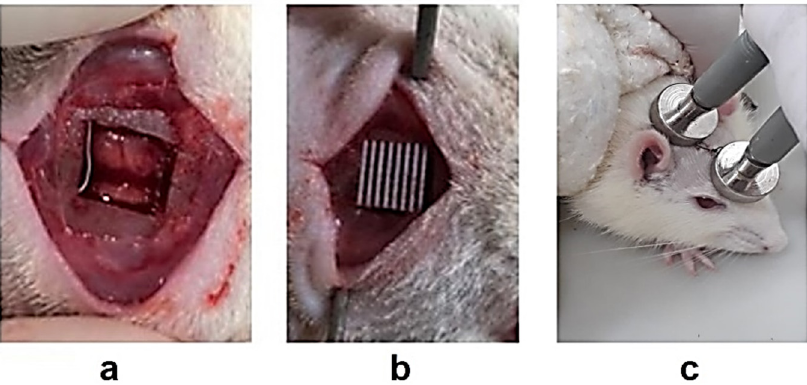
Figure 2. Scaffold implantation and electrical stimulation therapy. ( a ) Critical-sized bone defect; ( b ) implanted scaffold into the bone defect; ( c ) two electrode probes in contact with the animal for electrical stimulation.